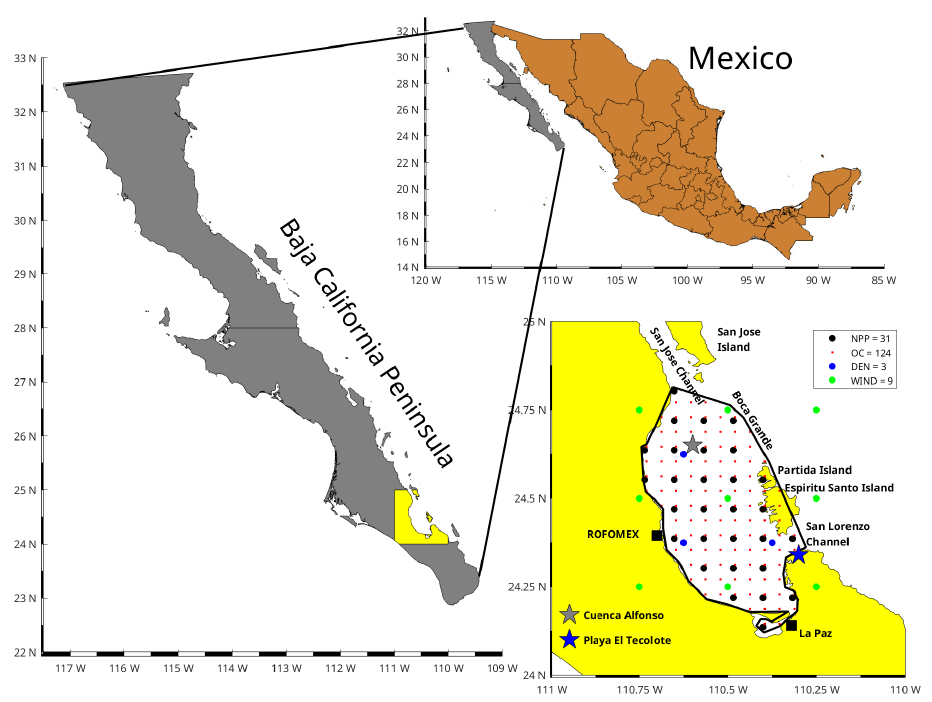
Figure 1. Overview of the Baja California peninsula and locations of the satellite data over Bahía de La Paz (BLP). The black circles indicate the pixels with net primary productivity (NPP) data. The red points indicate pixels with data of other variables obtained from Oceancolor (OC). The blue circles indicate density (DEN) data. The green circles indicate wind data. The black squares indicate the city of La Paz and the phosphorous mining complex (ROFOMEX). The black contour line represents the polygon of the study